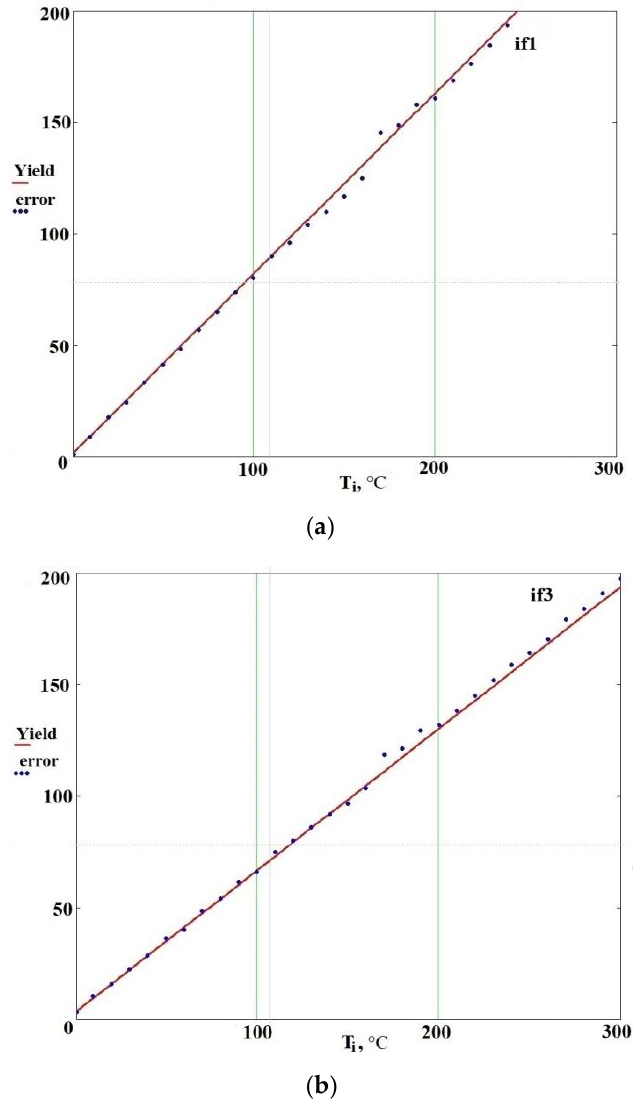
Figure 12. Observed versus predicted values of “ error ” . Dependence of “ error ” on temperature with fixed power consumption: ( a ) 0.2%, ( b ) 20%. fixed power consumption: ( a ) 0.2%, ( b )